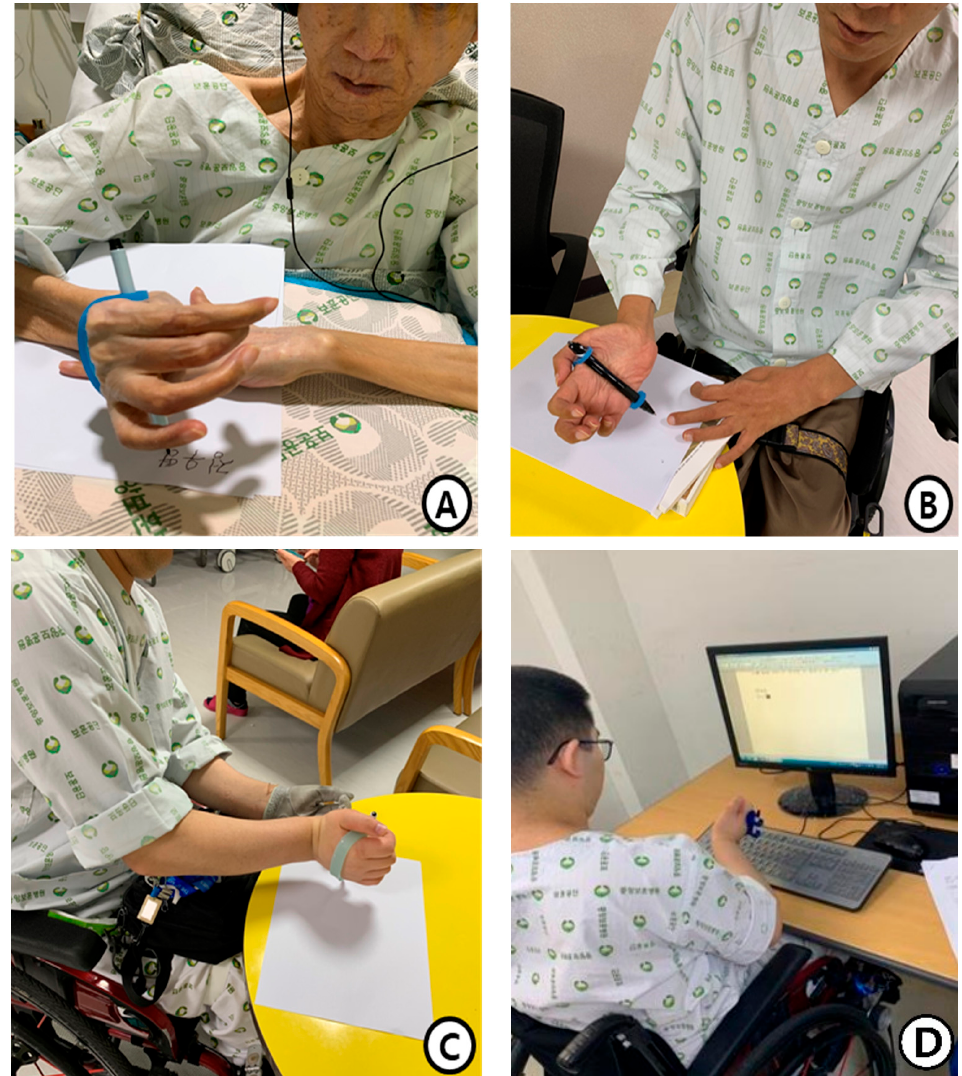
Figure 3. ( A ) Patient 1 wearing the fourth three-dimensional (3D)-printed writing integration device made of silicone material. ( B ) Patient 2 wearing the 3D-printed typing and writing integration device made of silicone material. ( C ) Patient 3 wearing the fourth 3D-printed typing and writing integration device made of silicone material. ( D ) Patient 3 wearing the 3D-printed typing integration device with the polylactic acid material.